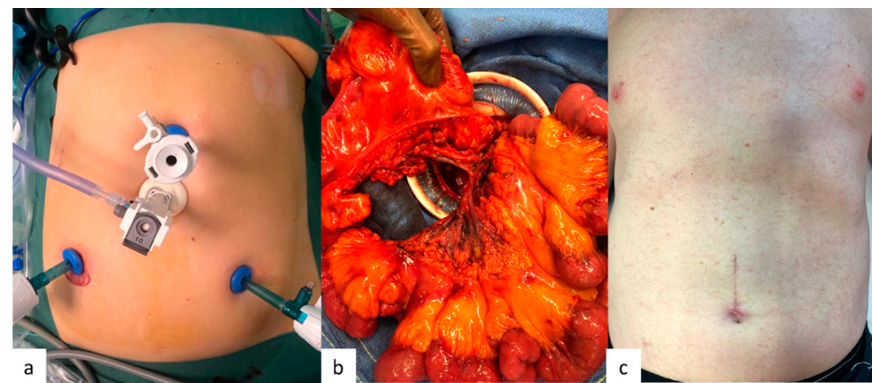
Figure 6. Operative view of a hybrid procedure combining laparoscopy and manual palpation of the entire small bowel. ( a ) Laparoscopic preparation; ( b ) Exteriorization of all the entire small bowel, the right colon, and the mesentery; ( c ) Postoperative scarce.